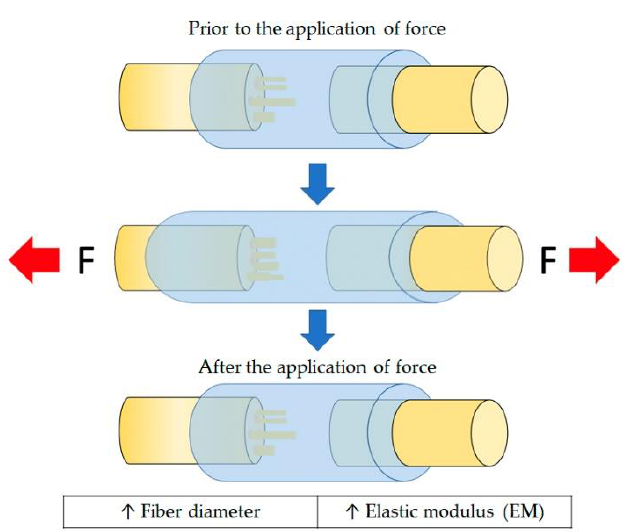
Figure 6. Schematic diagram of the modulus of elasticity (EM) of NGC. The direction of the horizontal arrows indicates the orientation of the applied force. The diameter of the fiber is directly proportional to the elastic modulus of the NGC.